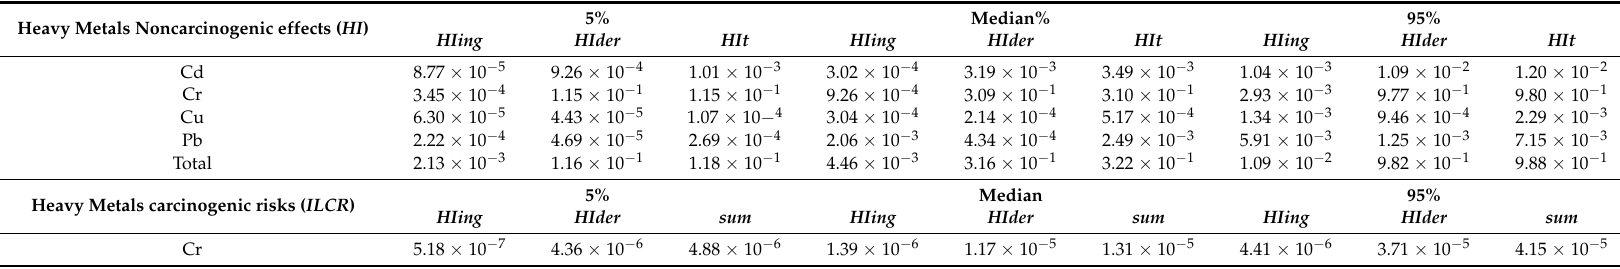
Table 8. Summary of Xining ( n = 38) non-carcinogenic Hazard Index ( HI ) and carcinogenic Incremental Lifetime Cancer Risk ( ILCR ) via ingestion and dermal exposure of DW based on HMs at the 5th, median and 95th